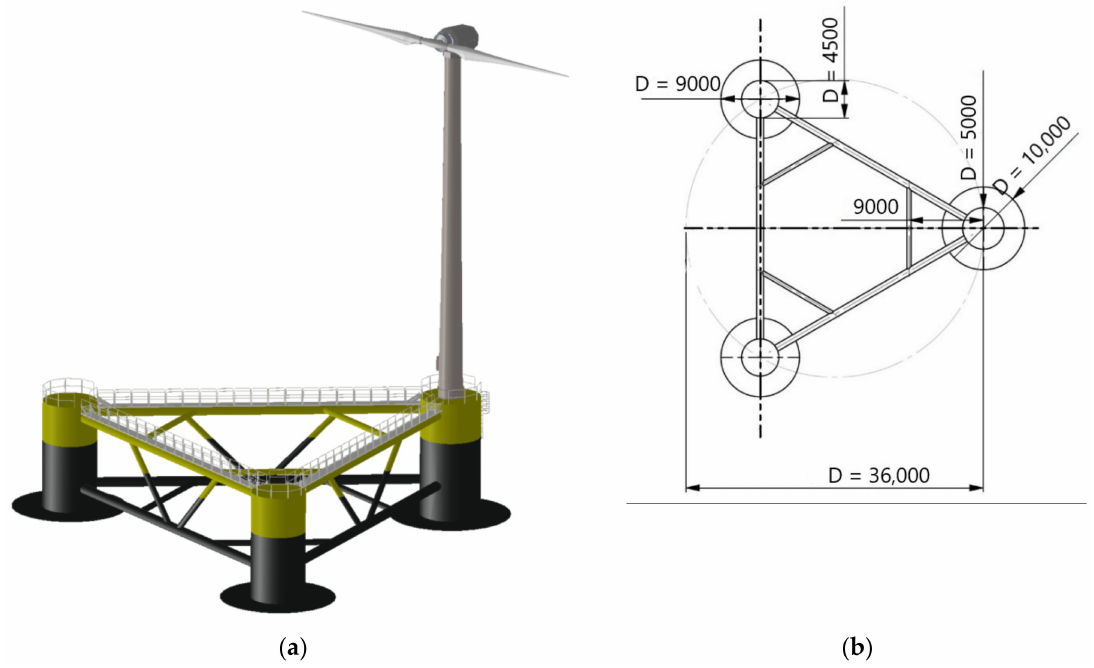
Figure 2. An impression CART wind turbine mounted on semisubmersible platform ( a ) and main dimensions of the floater ( b )